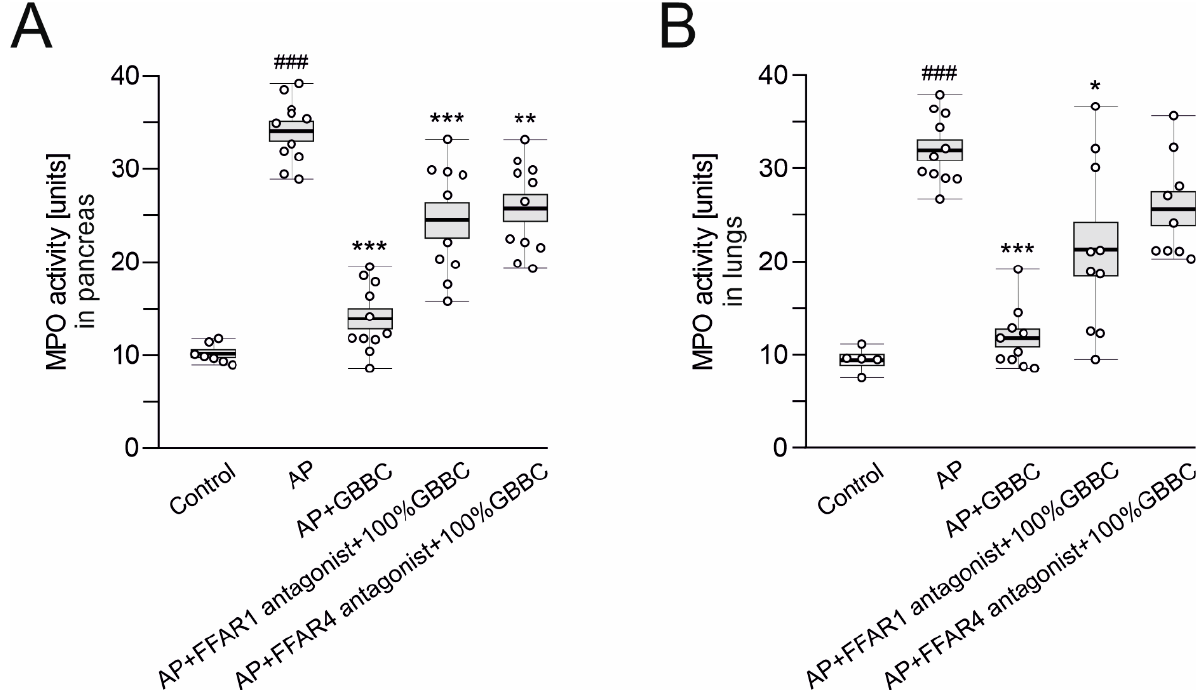
Figure 5. MPO activity level in pancreas ( A ) and lungs ( B ) of healthy mice, mice with evoked acute pancreatitis (AP), and mice with AP after administration of 100% GBBC and FFAR1 or FFAR4 antagonist. Data presented as raw data (circles) and means (horizontal bolded lines) with SEM (boxes). Significance estimated with the use of one-way ANOVA followed by Dunnett’s post hoc test. # (hash) denotes comparison to control. * (asterisk) indicates comparison to AP. n = 4–8; #/* denotes p < 0.05; ##/** denotes p < 0.01; ###/*** denotes p < 0.001.